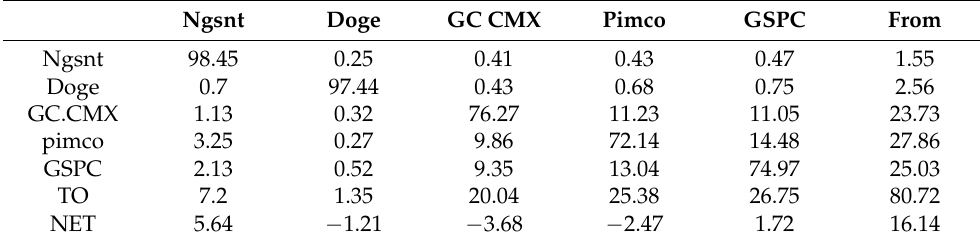
Table 3. Depicting average dynamic connectedness.